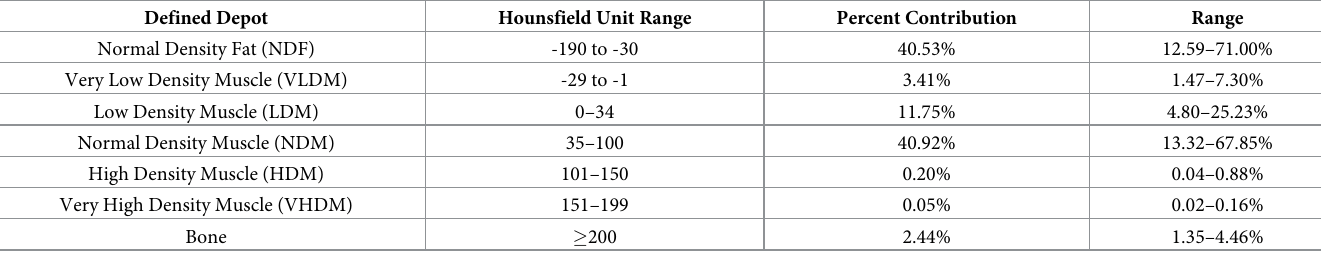
Table 2. Percent contribution of defined HU ranges to the overall total area of the